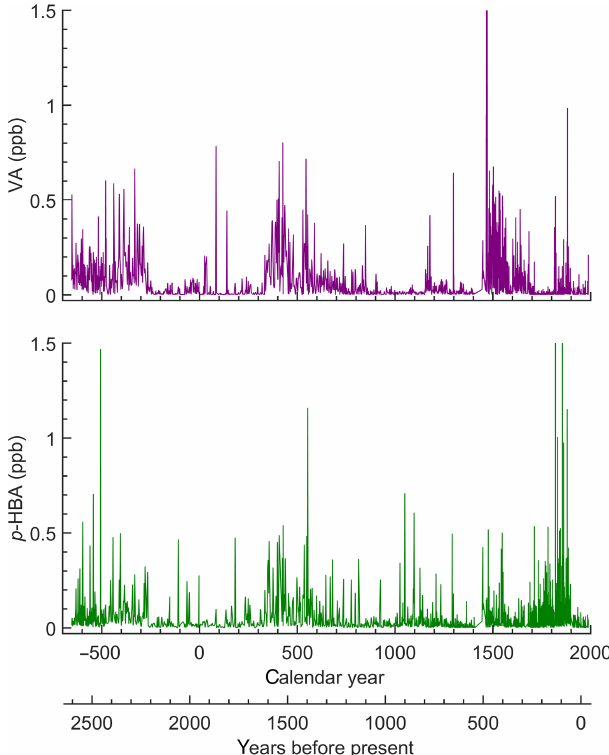
Figure 3. Akademii Nauk vanillic acid (top) and para - hydroxybenzoic acid (bottom) ice core